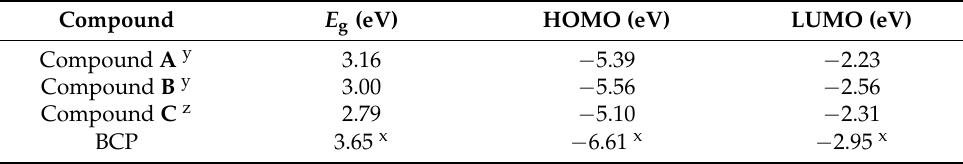
Table 4. Summary of the electrochemical properties of compounds A , B , and C . Compound E g (eV) HOMO (eV) LUMO (eV) Compound A y 3.16 Compound B y Compound C